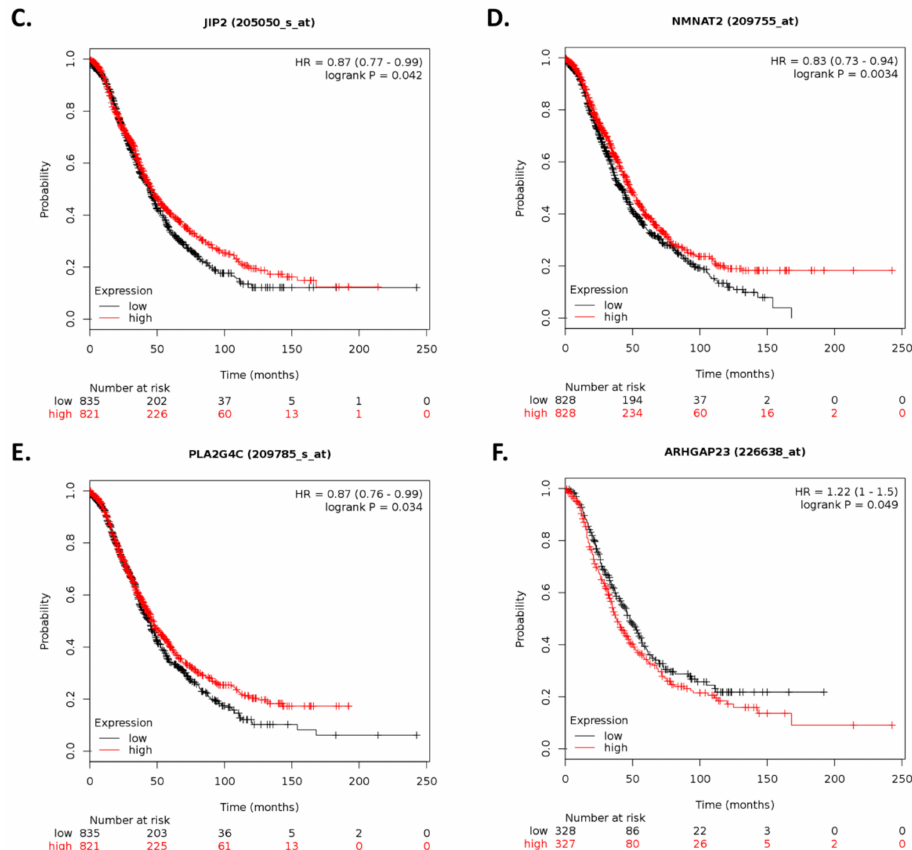
Figure 5. Kaplan–Meier plots for gene expression-based overall survival analysis. Survival plots of ovarian cancer patients were generated using Kaplan–Meier plotter (KM plotter). Overall survival (OS) of patients with ovarian cancer stratified by expression levels of ( A ) CHGA , ( B ) SLC5A1 , ( C ) MAPK8IP2 , ( D ) NMNAT2 , ( E ) PLA2G4C , and ( F ) ARHGAP23 is shown based on gene chip data. p -values < 0.05 were considered to be statistically